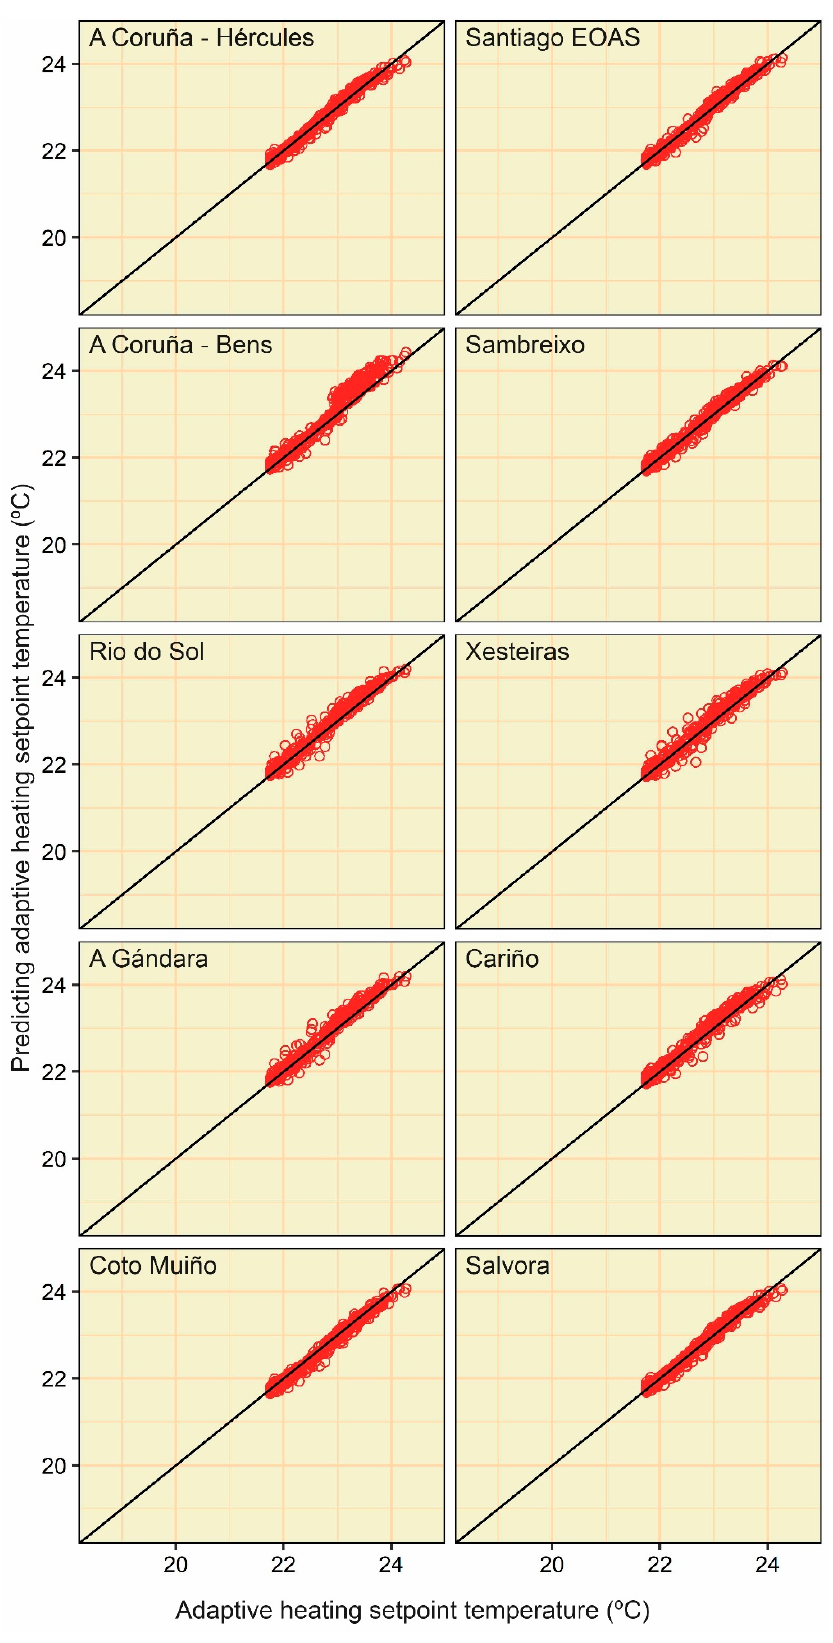
Figure A16. Point clouds between the actual and predicting adaptive heating setpoint temperature values (category I) of the MLP (approach 1).